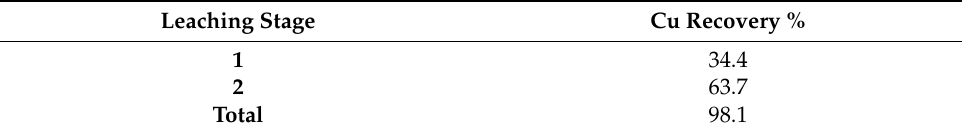
Table 3. Cu recovery during a two-stage leaching test.